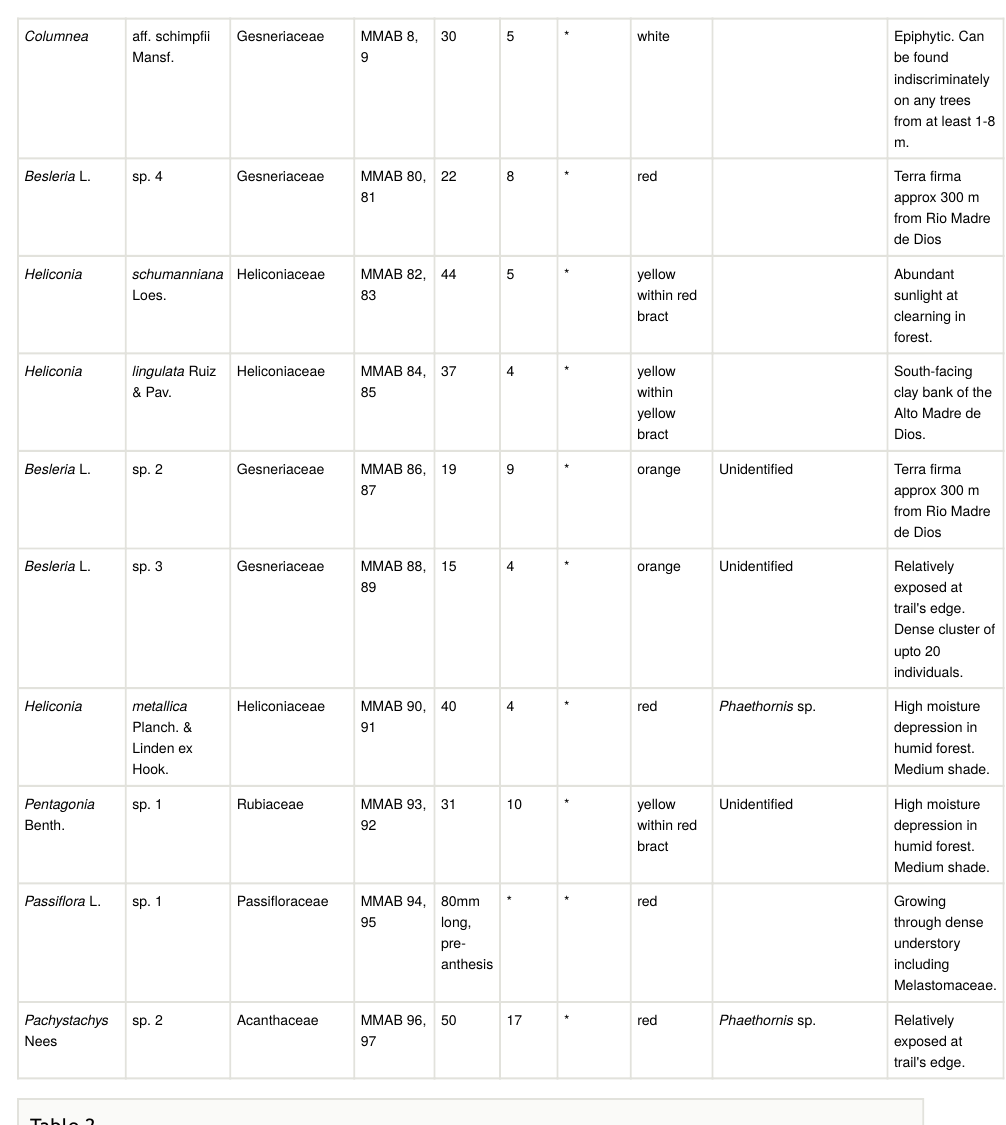
Table 2. Records of hummingbird-plant visitation along the Manú